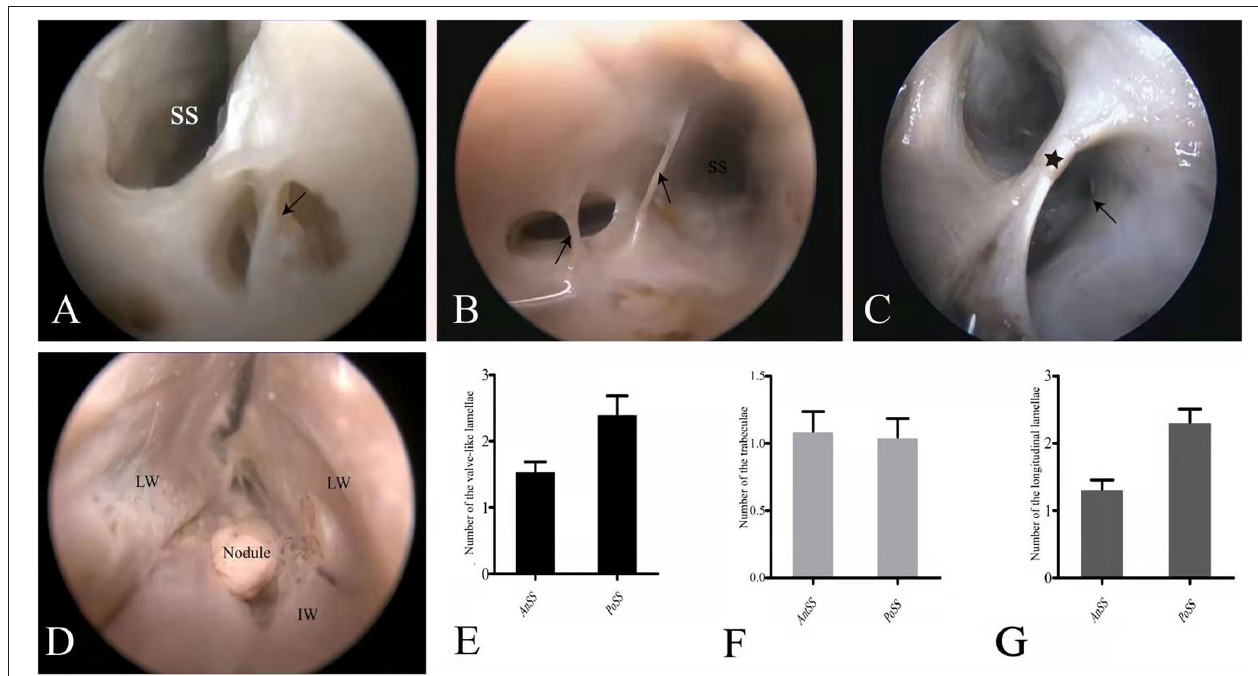
FIGURE 3 | Endoscopic view of the chordae willisii (CW). A valve-like CW in the SS was located at the junction between the LW and IW (black arrowhead: valve-like chorda) (A) . Two trabeculae in the lumen of the SS (black arrowhead: trabeculae) (B) . A longitudinal chorda inside the sinus divided the lumen into two channels (black star: longitudinal chorda). A valve-like chorda is present in the sidewall of one channel (black arrowhead: valve-like chorda) (C) . Nodule present at the junction between the great cerebral vein and the SS (D) . Graphs show comparisons of the number of valve-like lamellae (E) , trabeculae (F) , and longitudinal lamellae (G) in the AnSS and